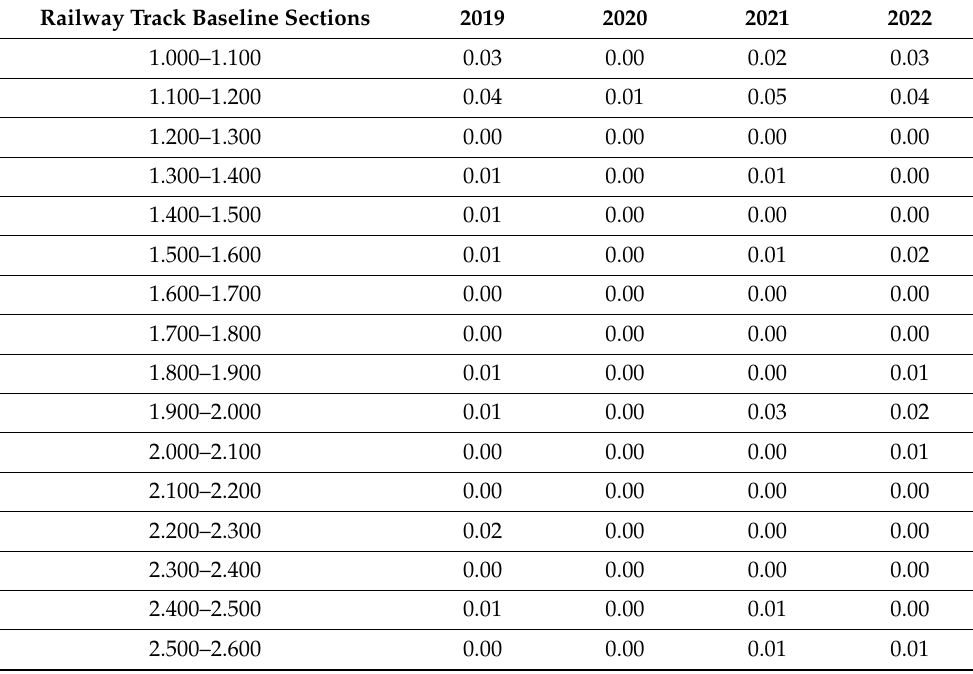
Table A12. Estimates of the railway track condition—relative D 6 , object No. R 143_1_2. Railway Track Baseline Sections